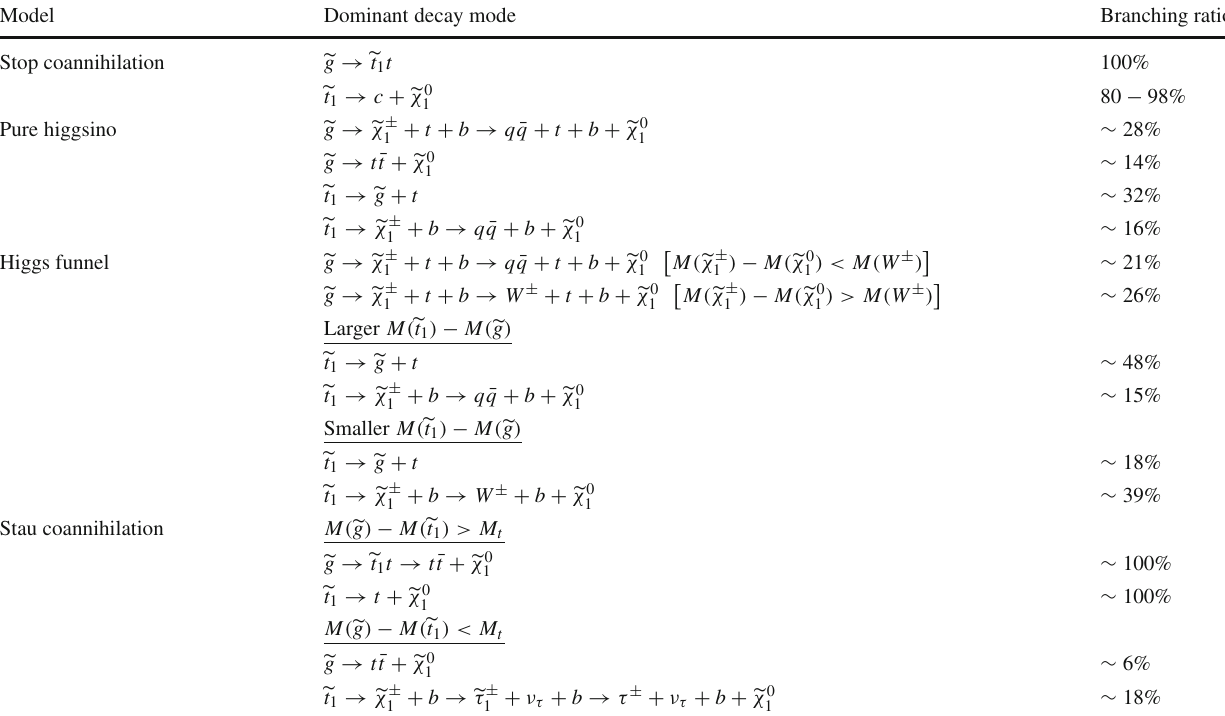
Table 4 Dominant gluino ( (cid:2) g ) and light stop ( (cid:2) t 1 ) decay modes for each of the regions of the model space we study in this work, along with the associated branching ratios. Here, q = ( u , d , c , s ) and (cid:2) q = ( (cid:2) u , (cid:2) d , (cid:2) c , (cid:2) s ) Model Dominant decay mode Branching ratio Stop